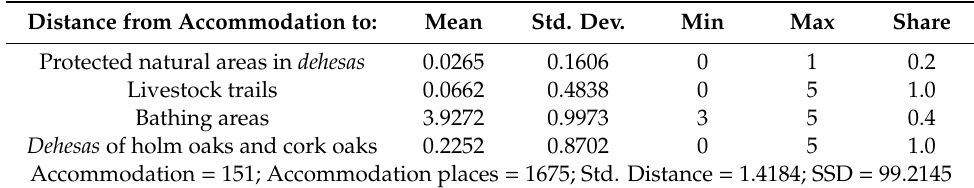
Table 12. Overall variable statistics.